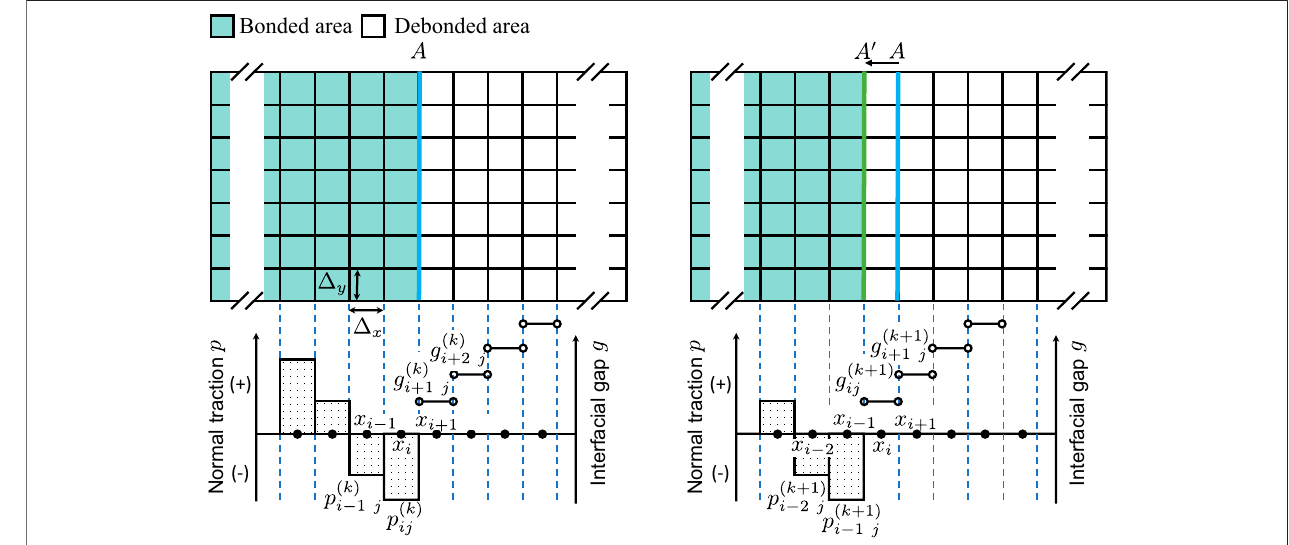
FIGURE3| Schematicsofnormaltractionandcrackopeningdisplacementbetweenarigid fl atand fl exiblesurfaceatthevicinityofthecrackfront A (atstep k , left ) and A ′ (at step k + 1, right ).